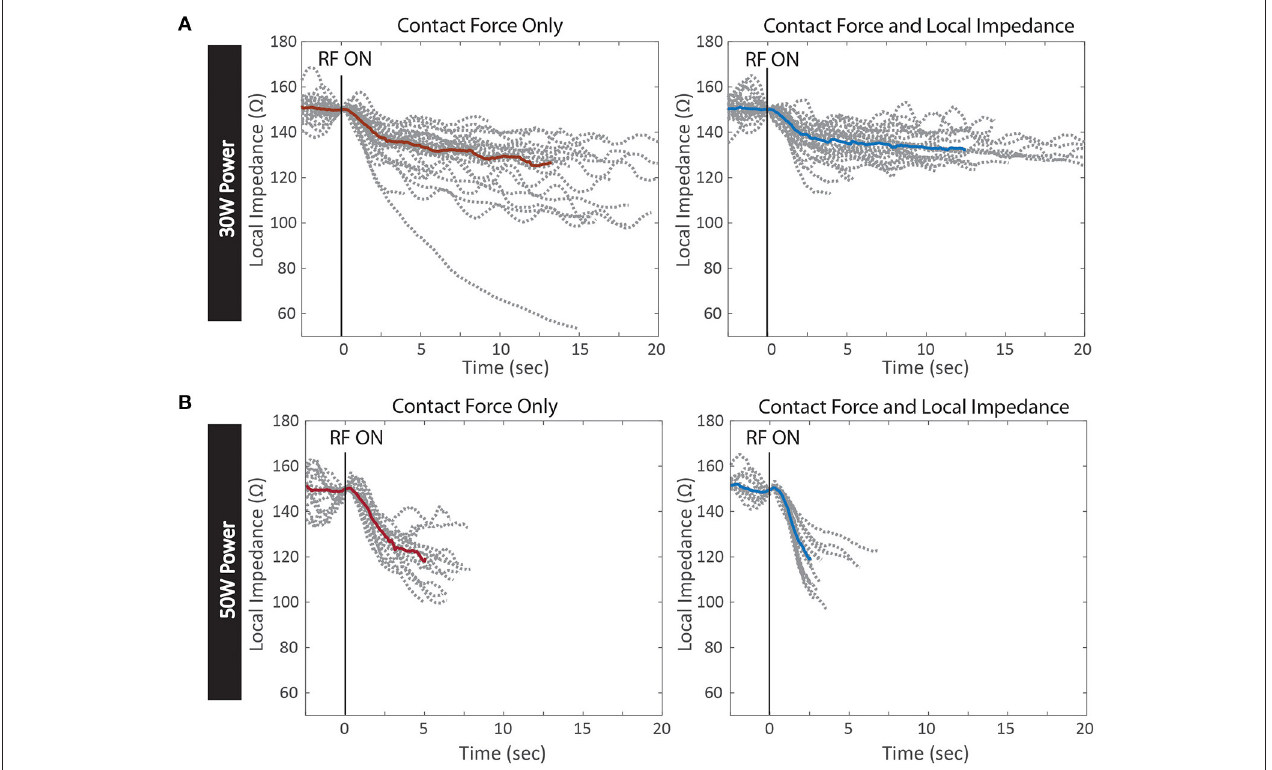
FIGURE 6 | Kinetics of Local Impedance Drop per Test Conditions. Local impedance drops from RF applications of a representative PV isolation in each test condition. All drops are normalized to the same starting impedance at the onset of RF energy. The median drop in each condition is overlaid in red for Contact Force only and blue for Contact Force and Local Impedance (A) 30W power cohort with Contact Force only (left) and Contact Force and Local Impedance (right) (B) 50W cohort with Contact Force only (left) and Contact Force and Local Impedance